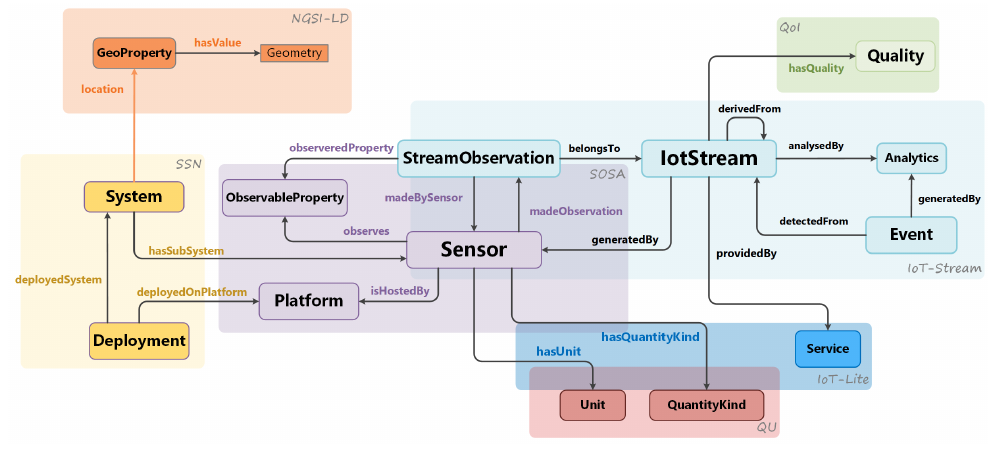
Figure 2. IoTCrawler information